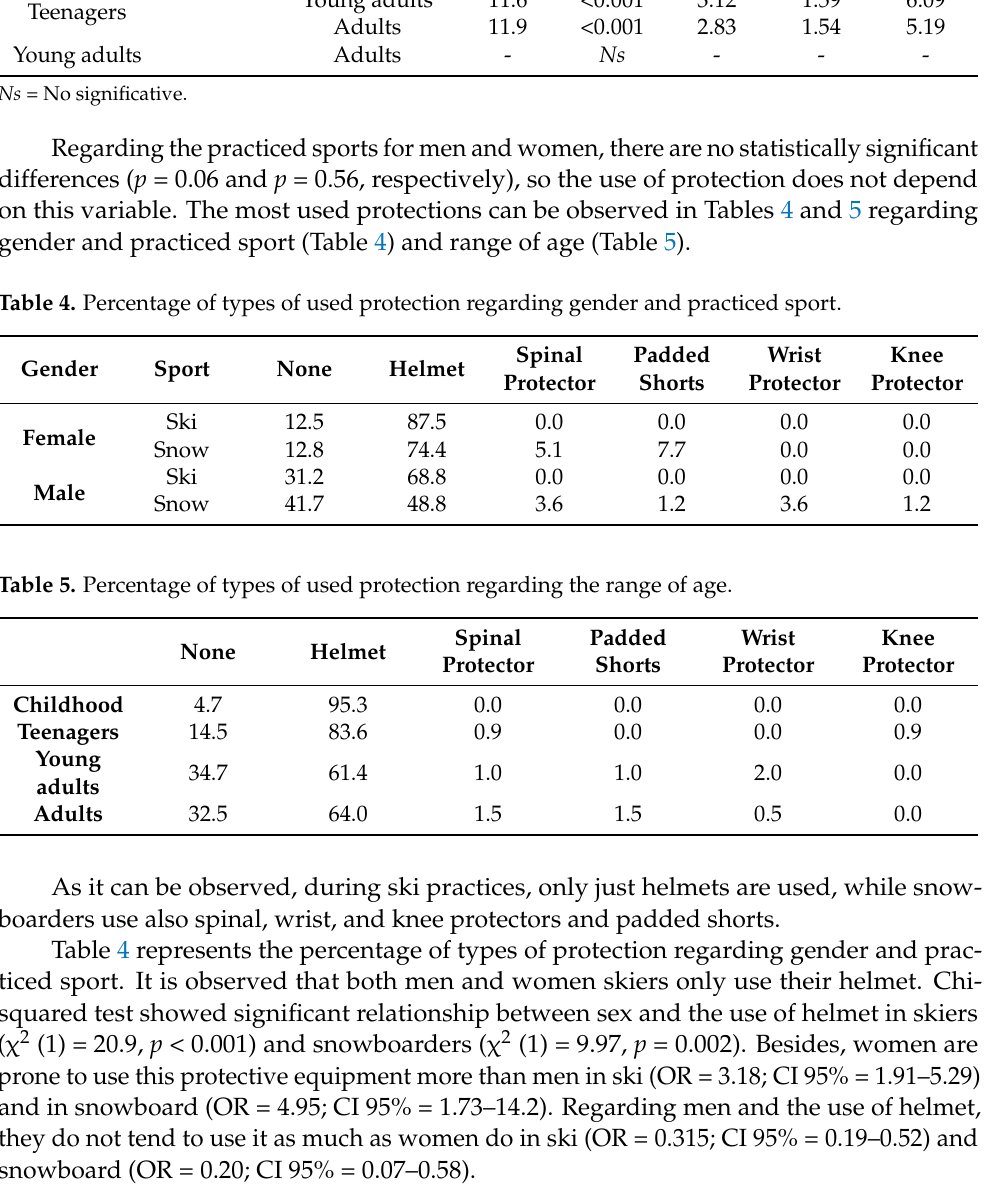
Table 3. Relative odds of use protective supplies based on the development stage. Development χ 2 (1) p OR Lower Upper Stage Teenagers Childhood vs Young adults Teenagers Young adults Adults - Ns - Ns = No significative.